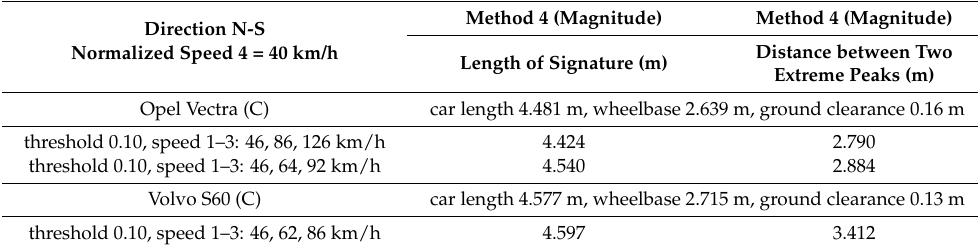
Table 3. Signature lengths and two-extreme-peak distances computed by means of method